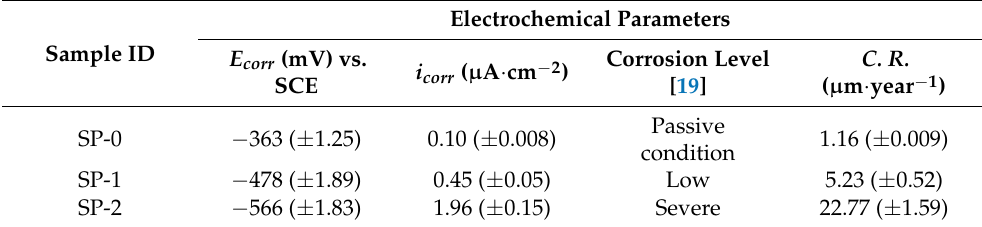
Table 4. Electrochemical parameters of steel